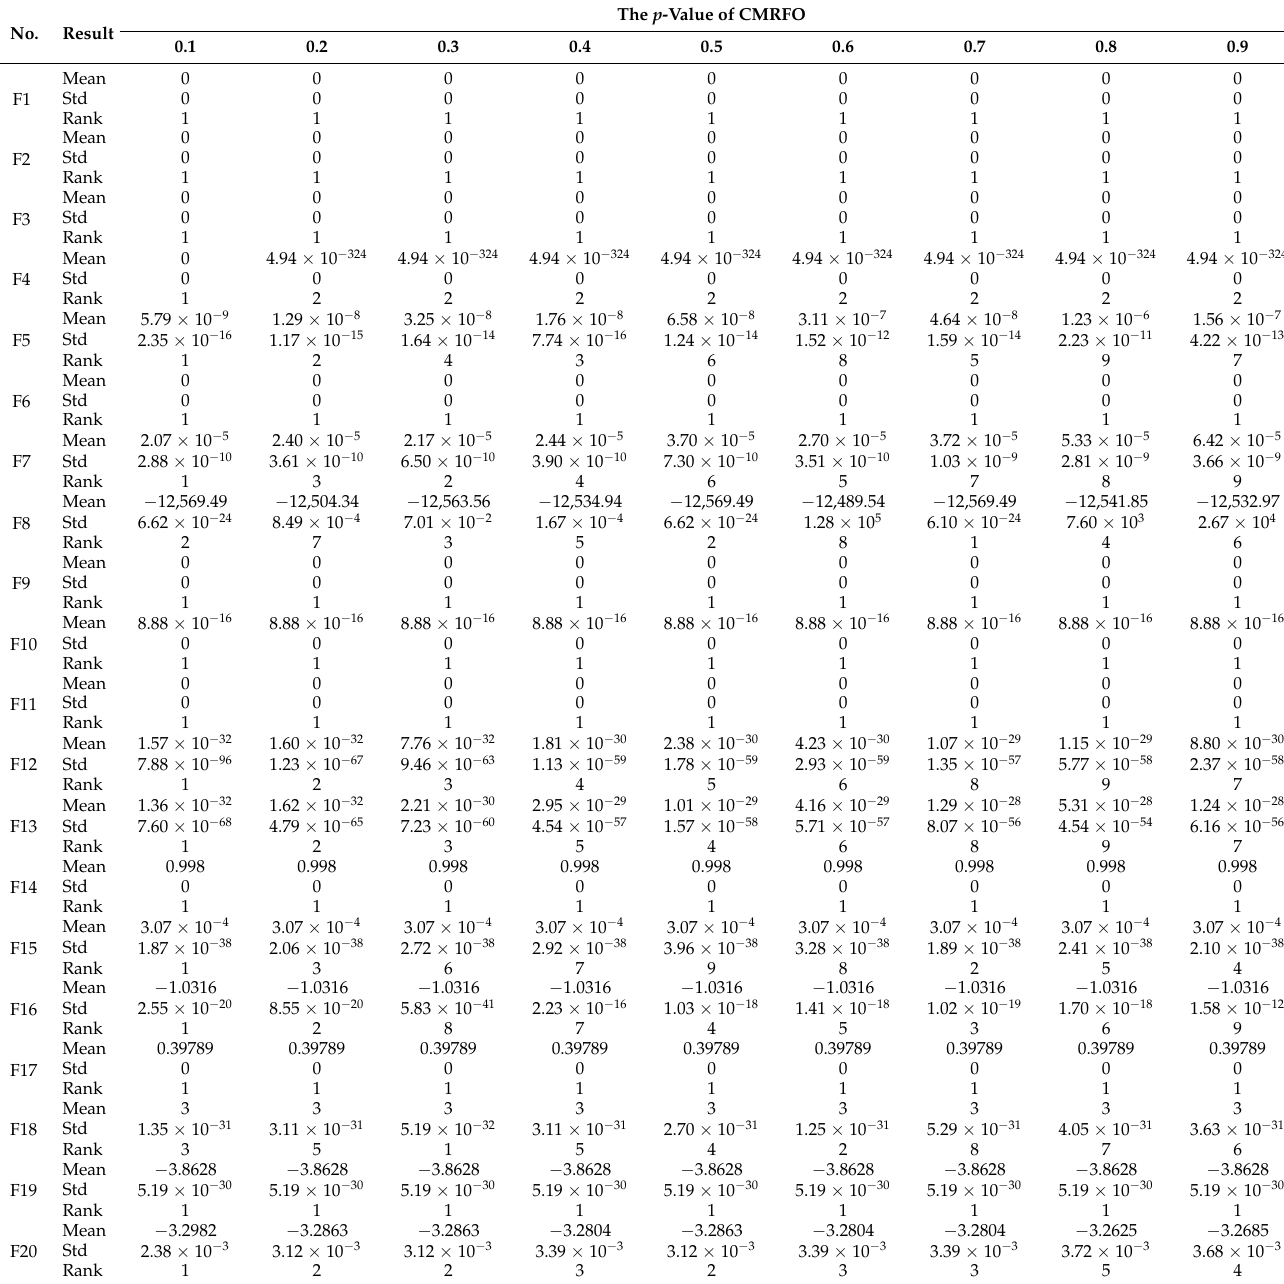
Table 4. Results of the CMRFO based on different p